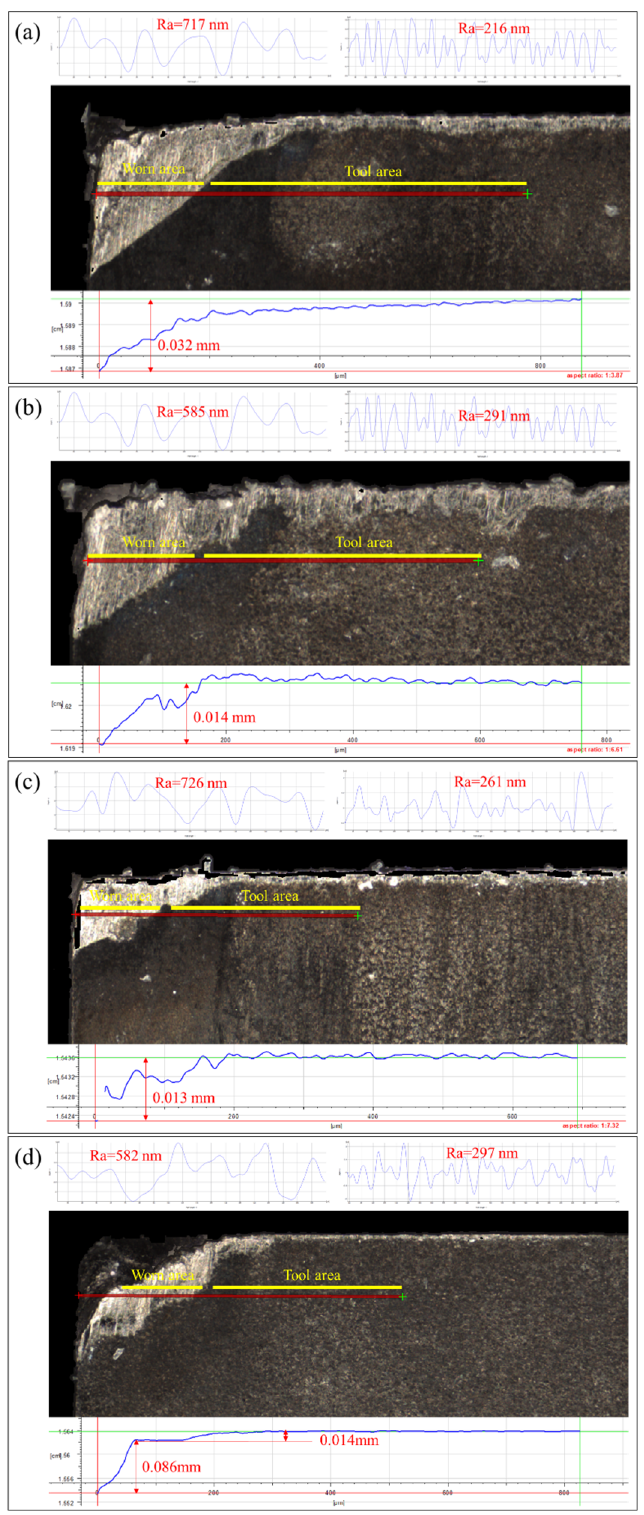
Figure 7. Profile and roughness of the primary flank faces of different PCD inserts: ( a ) 002A, ( b ) 002E, ( c ) 302A, and ( d ) 302E. ( c ) 302A, and ( d )